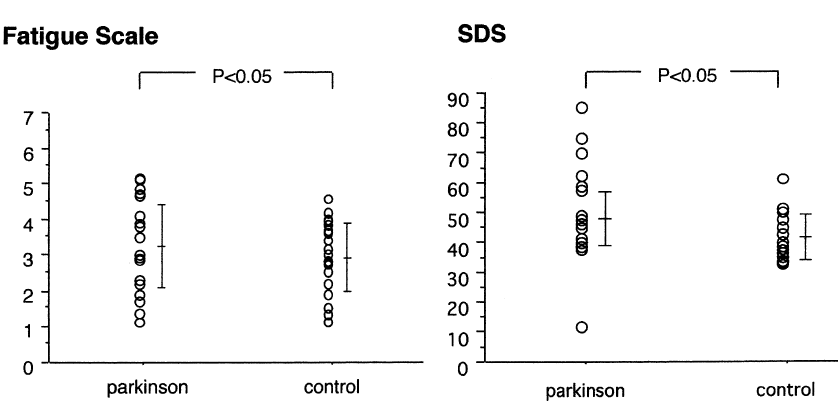
Fig.1. Comparison ofthe fatigue scale andthe selfassessed depression scale. There were significant differences between patients with Parkinson’s disease and controls both in the fatigue scale and the self assessed depression scale (SDS). The vertical bars denote mean ± standard deviation.